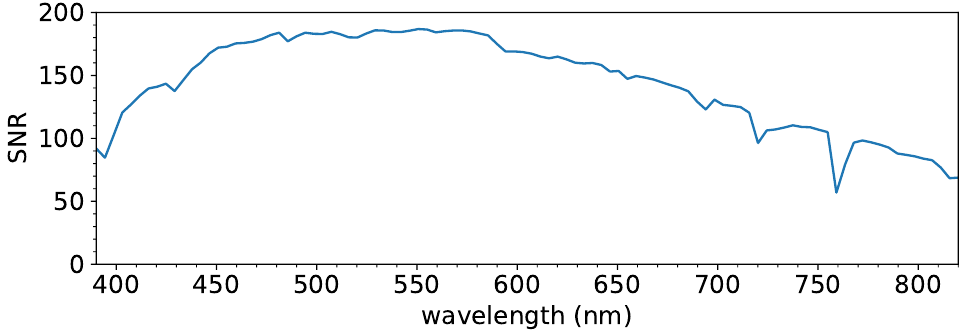
Figure 5. OpenHSI SNR curve (10 ms exposure and 4 nm spectral